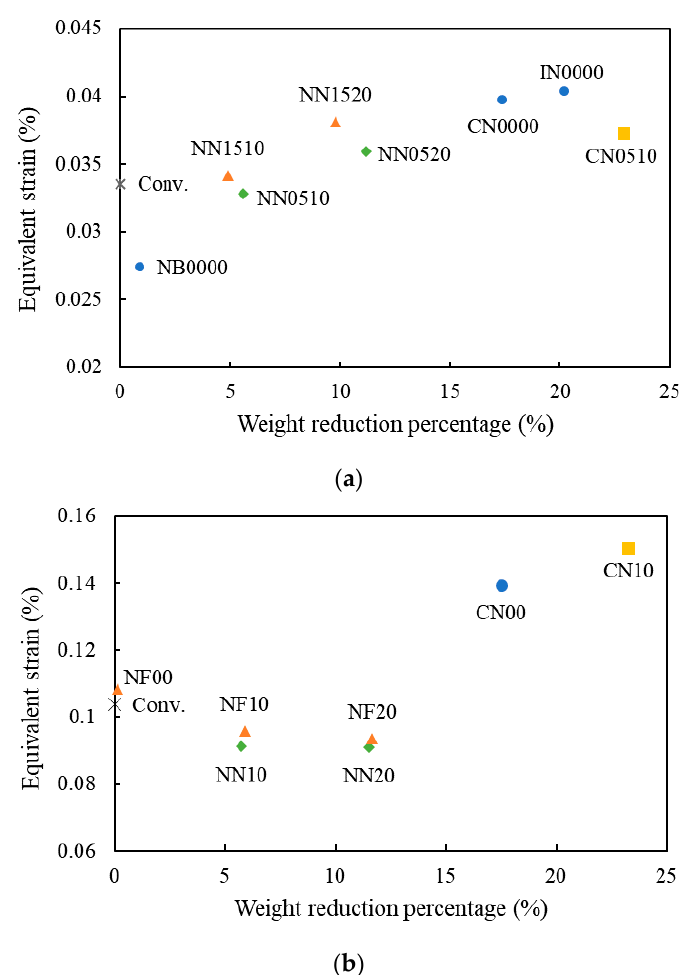
Figure 6. Weight and strain relationship of various end plate types for ( a ) circular and ( b ) square end plates.